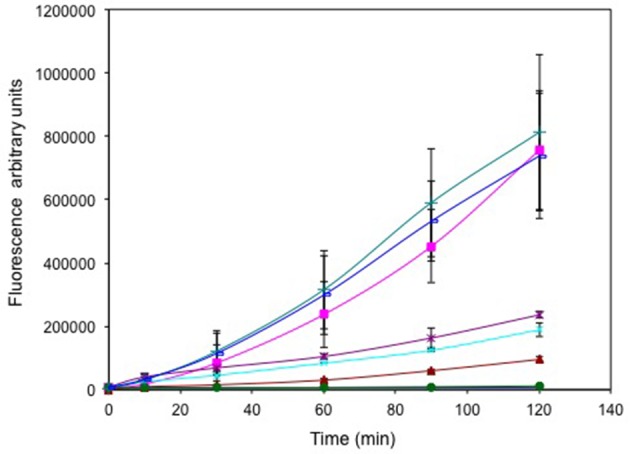
Time course of reactive oxygen species (ROS) production. Exponentially growing cells were washed, suspended in saline in the presence of the ROS sensitive probe carboxy-DCFH-DA and exposed to metals. 800 μg/mL selenite (green triangle), 25 μg/mL tellurite/800 selenite (blue line), 1 μg/mL tellurite (brown *), 0.25 μg/mL tellurite (cyan X), 0.125 μg/mL tellurite (brown triangle), 25 μg/mL tellurite (solid green circle). ROS production in non-treated (blue solid diamond) and cells treated with H2O2 (pink square) are presented as negative and positive controls respectively. The error bars represent the standard deviation between 3 trials.